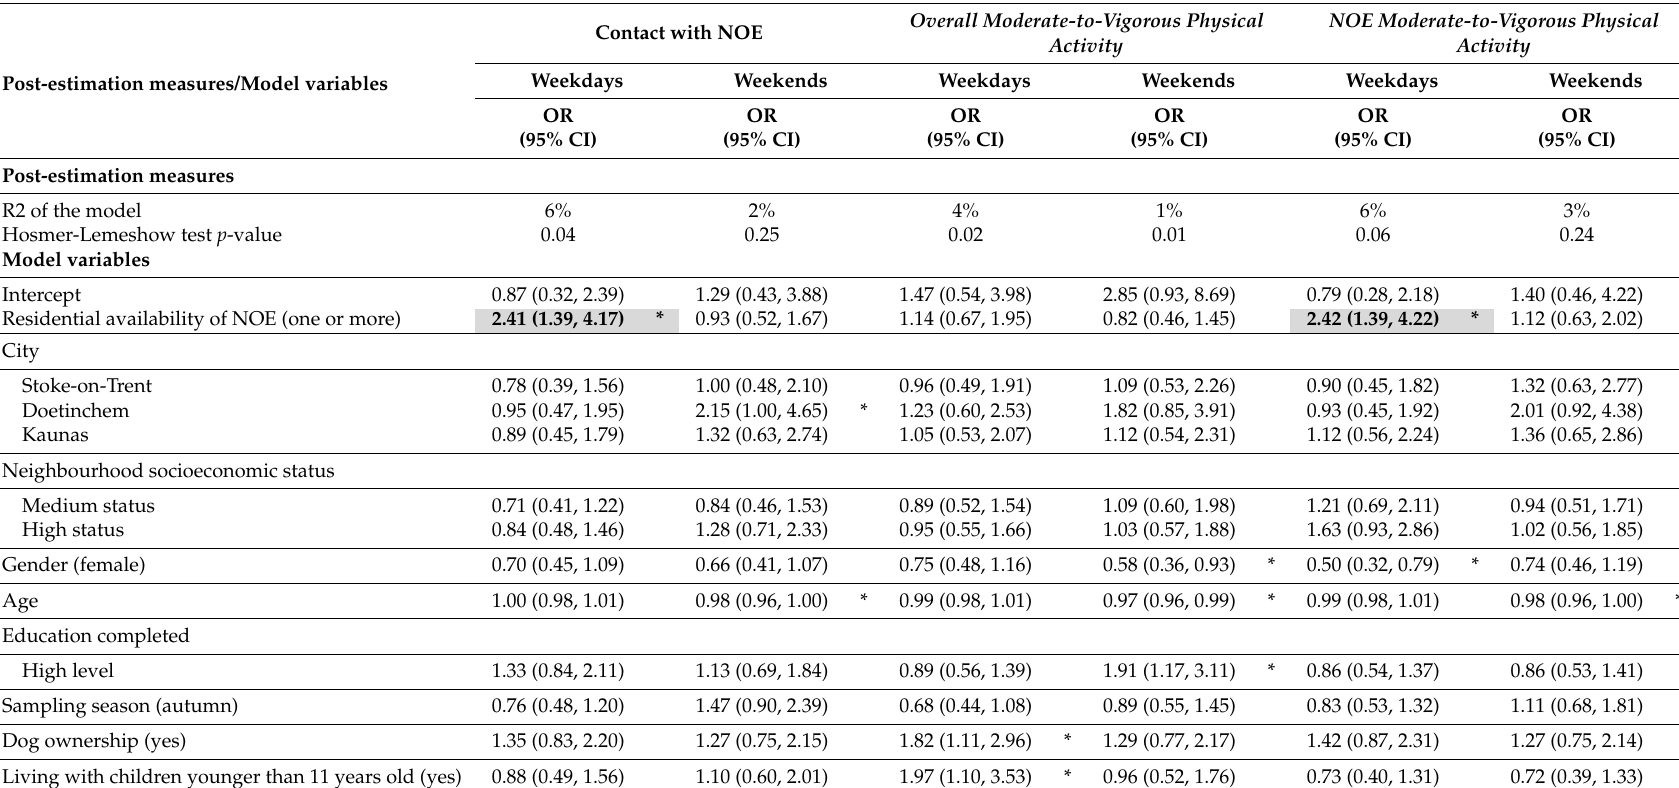
Table 2. Adjusted models for residential NOE availability at 300 m network